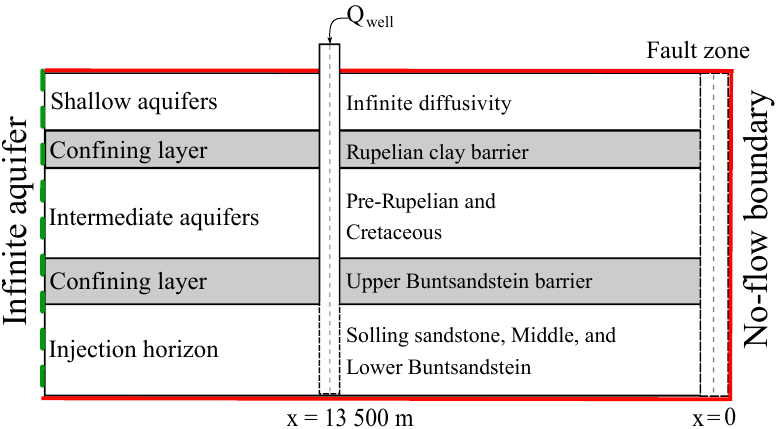
Figure B1. Model setup for the Analytical Model with two permeable layers (injection horizon and intermediate aquifers) and the shallow aquifers with infinite